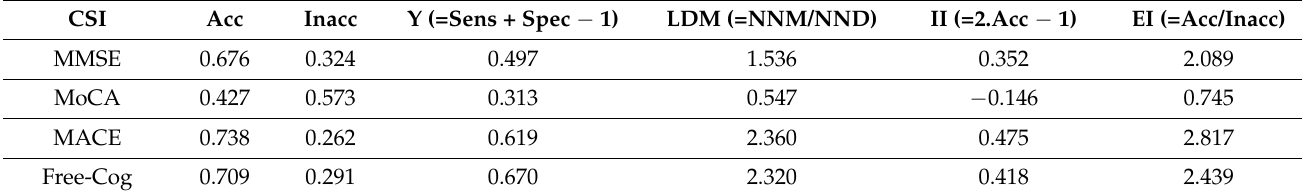
Table 2. Comparing metrics for diagnosis of dementia vs. no dementia by CSI (using cut-offs in Table 1).